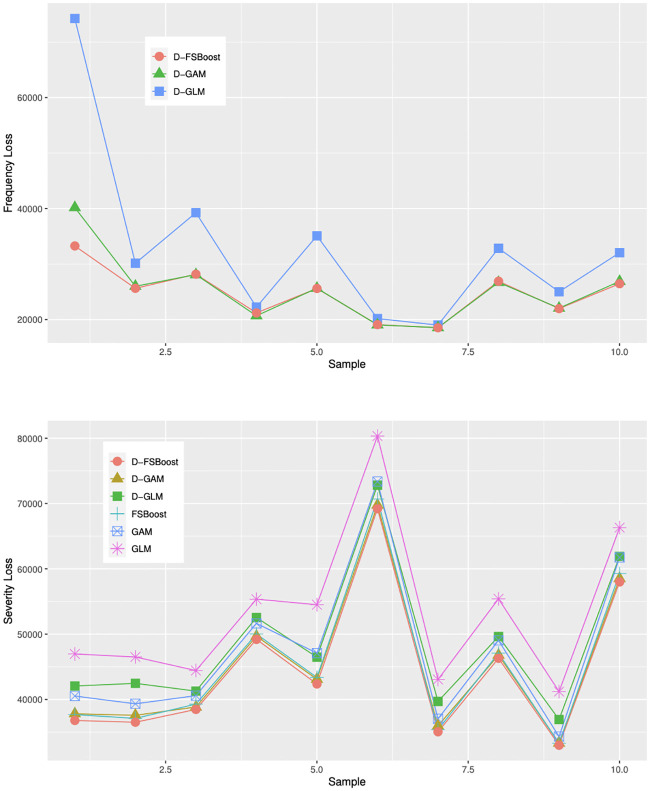
Out-of-sample loss.